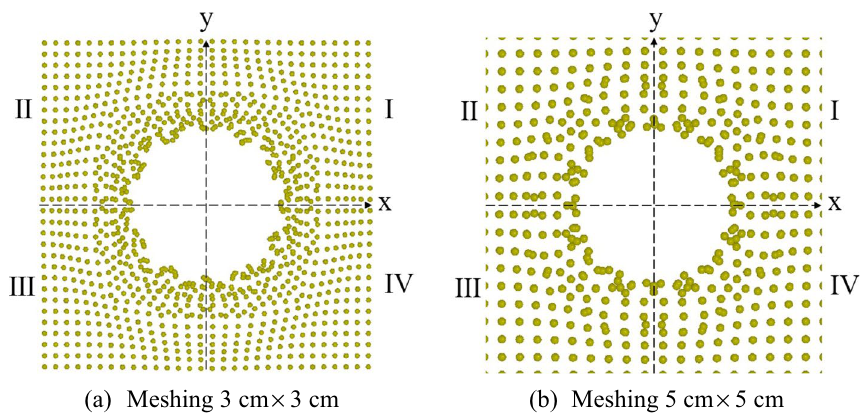
Fig. 7 Particle motion with different mesh size. a Meshing 3 cm × 3 cm b Meshing 5 cm × 5 cm